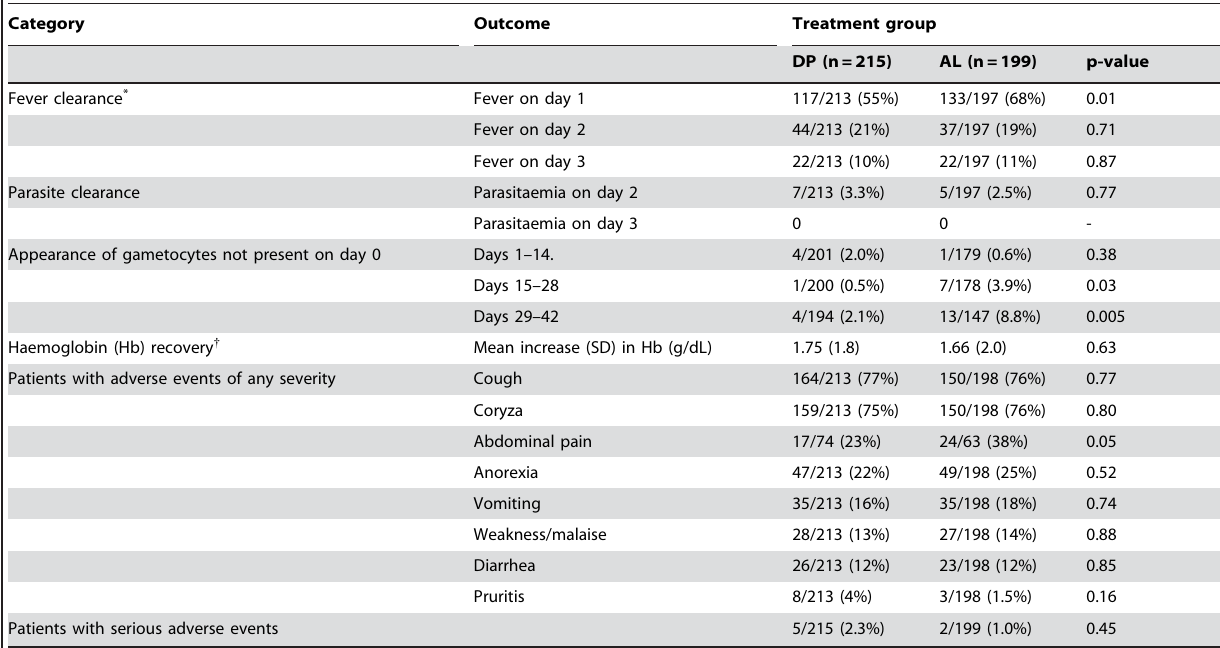
Category Outcome Treatment group